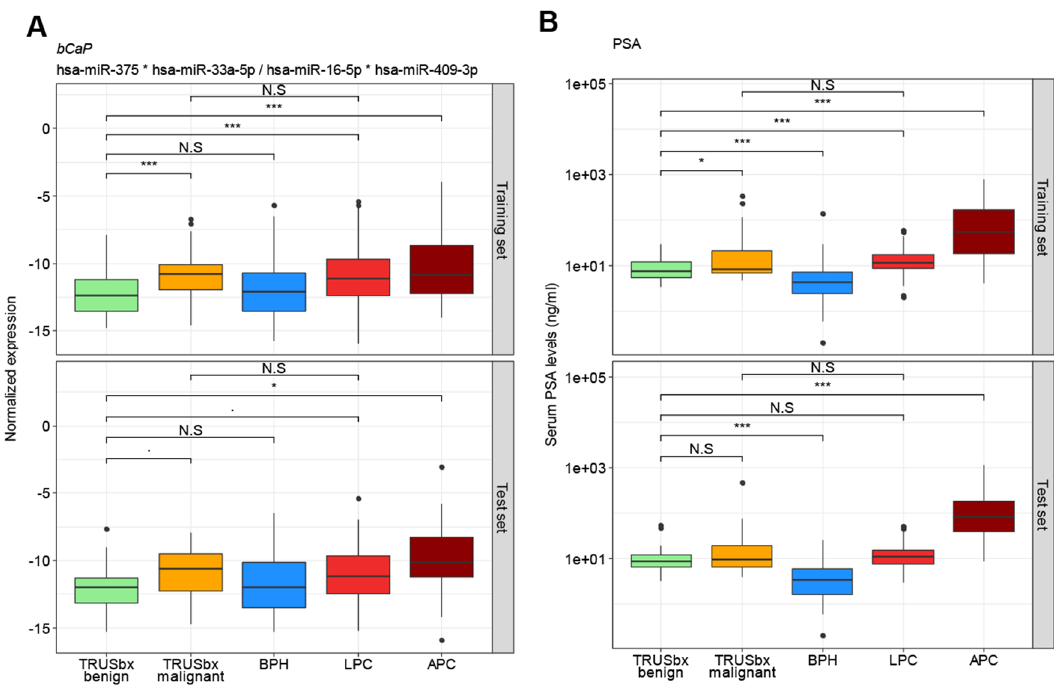
Figure 1. Box plot analysis for the four-miRNA diagnostic model bCaP (miR-375*miR-33a-5p / miR-16-5p*miR-409-3p) ( A ) and PSA ( B ) in the training (top) or test (bottom) sets. Boxes represent the first and third quartiles. The median is shown as a horizontal line and dots indicate outliers. p values indicate the difference in median, by Wilcoxon rank sum test. N.S = not significant ( p > 0.05), ∙ = p < 0.1; * = p < 0.05; *** = p < 0.001; BPH (blue): benign prostatic hyperplasia; LPC (red): localized prostate cancer; APC (dark red: advanced prostate cancer; TRUSbx (green and orange: transrectal ultrasound (TRUS) guided biopsy; PSA: prostate specific antigen.